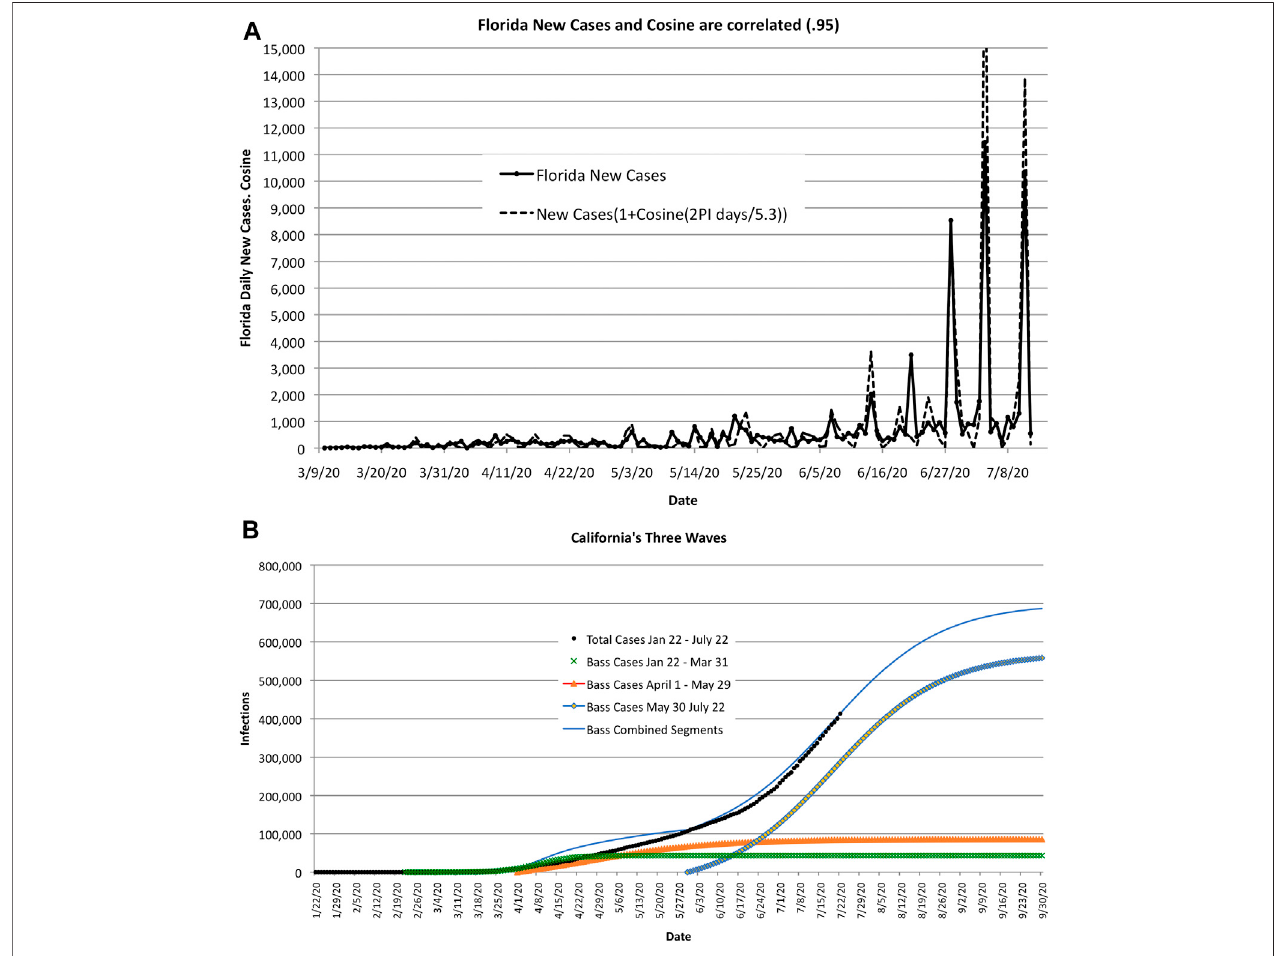
FIGURE9| AsCOVID-19 encounters clustersoflarge populations, the estimateofsizeand duration increases. The errorintheseestimates may becaused bythe time shift and magnitude of the infected clusters or shifts in public sentiment, as illustrated by the two examples shown here. (A) . High-frequency wave-like behavior in Florida. The correlation coef fi cient between actual new cases and cosine waves is 0.95 for 5.3-day cycles. (B) . Long wave-life surges in California caused by “ mini- epidemics ” recurring with different start times and amplitudes.